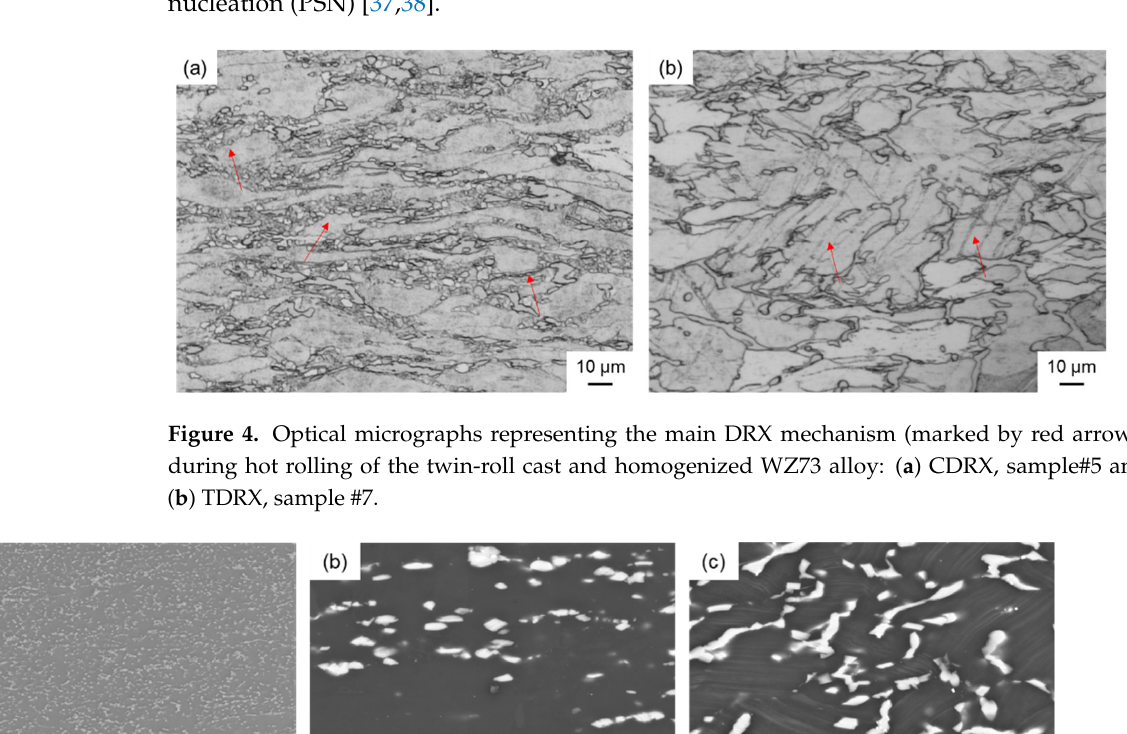
Figure 4. Optical micrographs representing the main DRX mechanism (marked by red arrows) dur- ing hot rolling of the twin-roll cast and homogenized WZ73 alloy: ( a ) CDRX, sample#5 and ( b ) TDRX, sample #7.